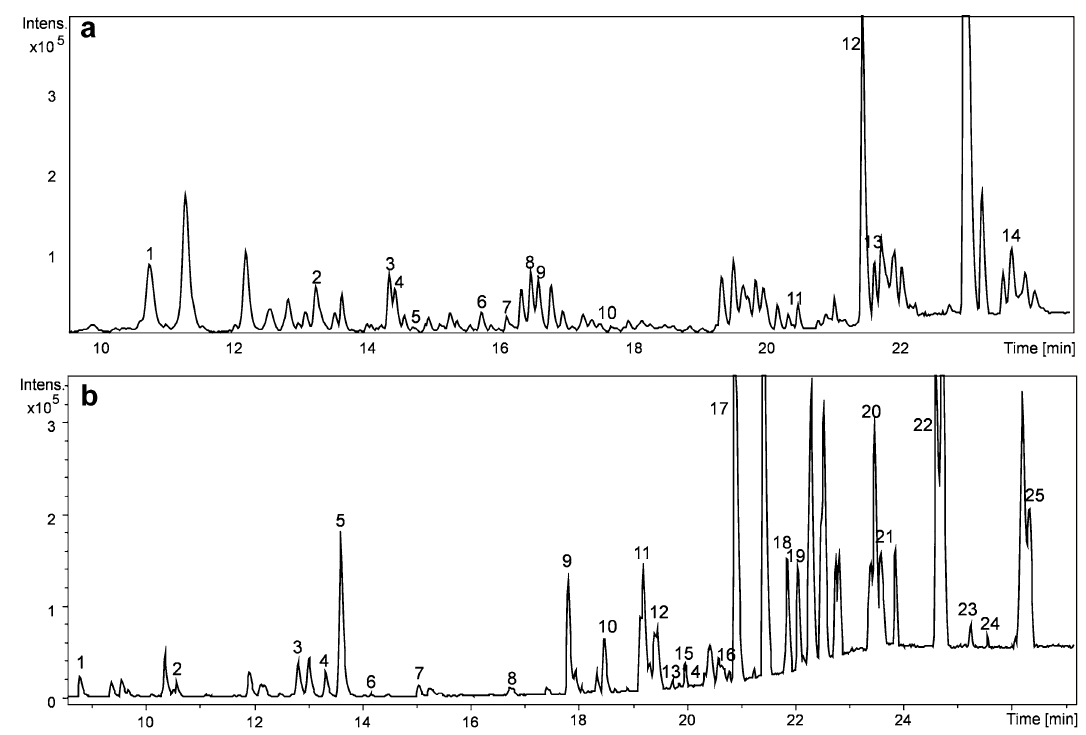
Fig. 2 The Base Peak Chromatogram (BPC) of fraction a and b analyzed by GC-APCI-MS, fourteen peeks were identified in a and twenty-five peeks were identified in b . Some compounds may flow out at same